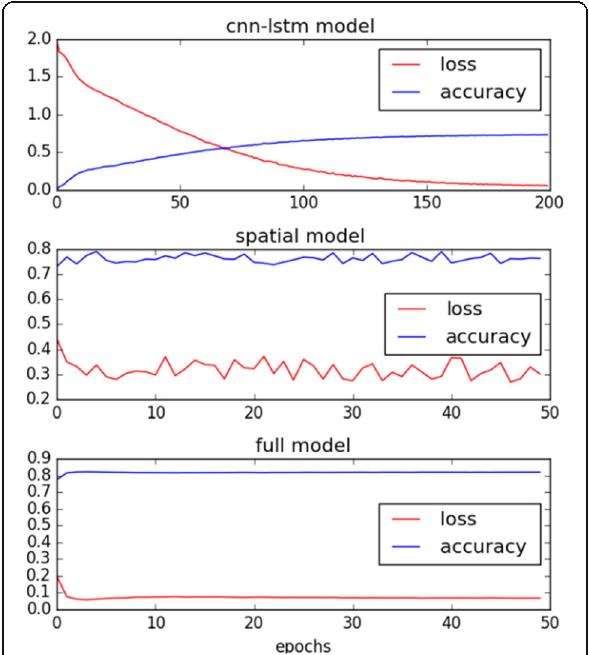
Fig. 7 Loss and accuracy of three different